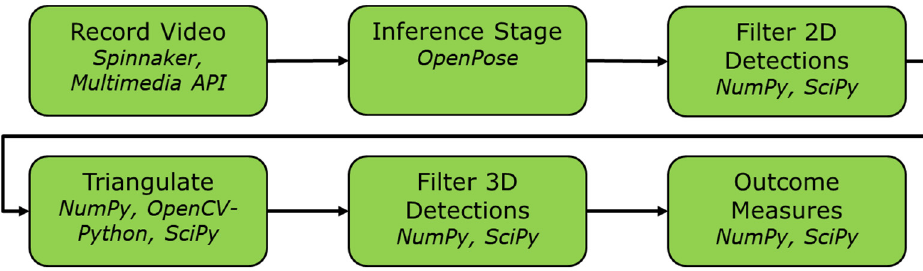
Figure 7. Software pipeline and libraries (in italics) used for the Smart Hallway.